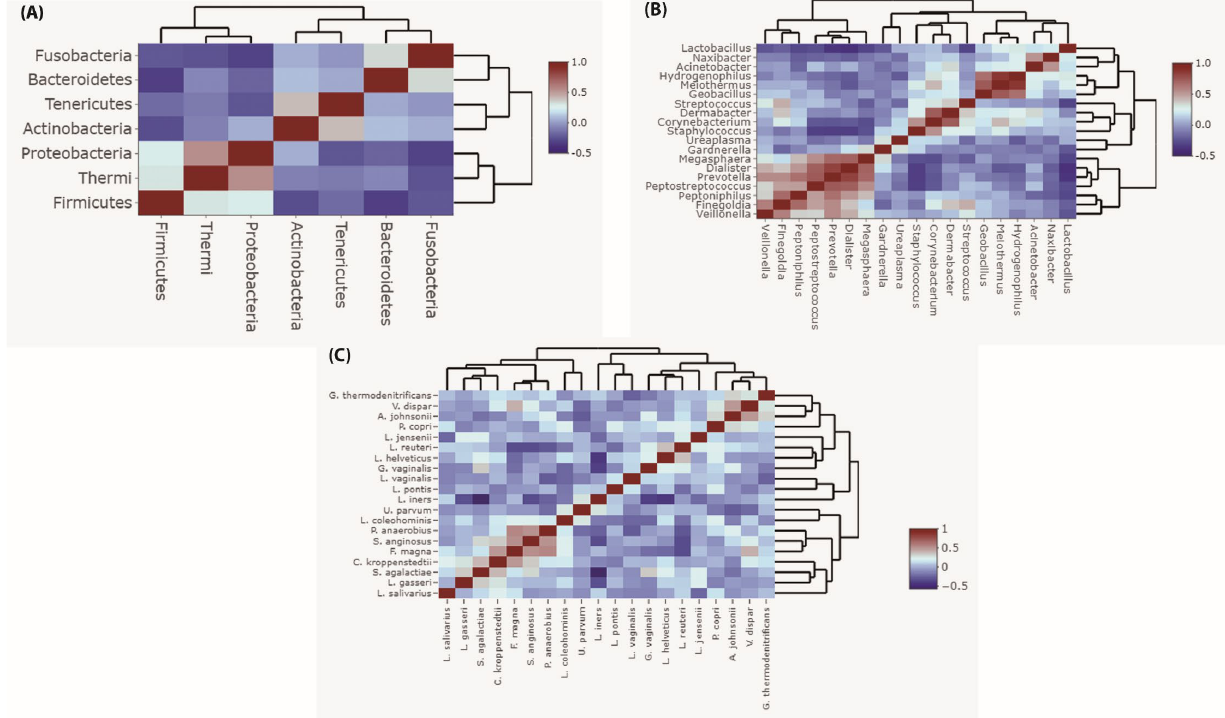
Figure 6. Correlation plot for dominant taxa during pregnancy . ( A ) Correlation plot for dominant phyla. ( B ) Correlation plot for dominant genera. ( C ) Correlation plot for dominant species. Positive correlation strength relationship is shown in red and negative correlation strength relationship is shown in blue. The plot was generated using Spearman’s correlation coefficients between each taxon and all other taxa.